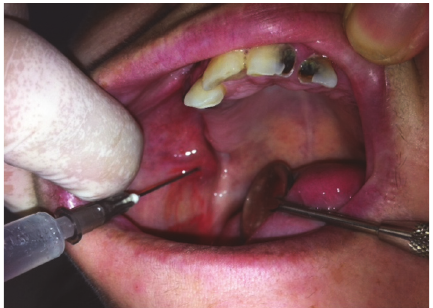
Figure 4: Second intralesional injection of aethoxysklerol 1%.